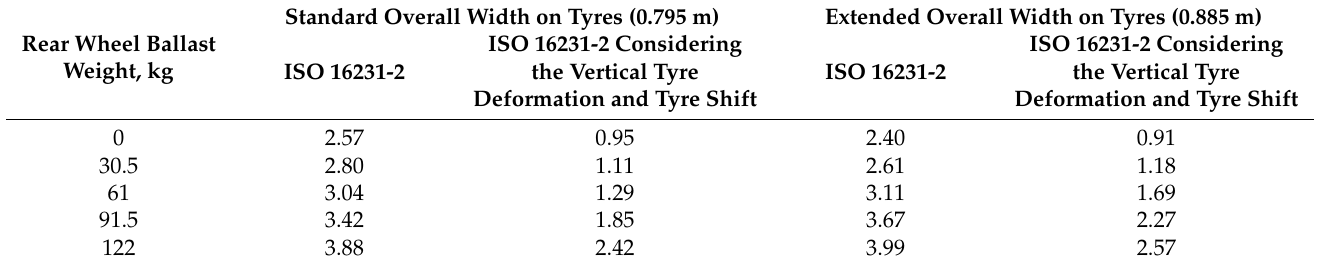
Table 7. Percentage difference between calculated and experimental data.